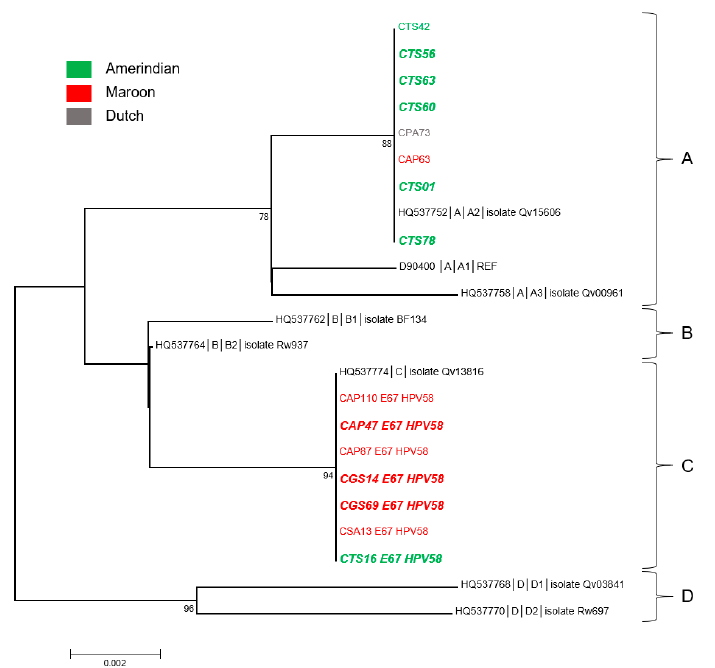
Figure 5. Phylogenetic tree of HPV58 variants from French Guiana. Maximum likelihood phylogenetic tree of HPV58 variants based on 741 bp of E6 and E7 concatenated sequences. Four clusters were identified as lineages A, B, C, and D. Only bootstrap values above 70% are represented in the branches. The tree is drawn to scale with branch lengths measured in the number of substitutions per site. Newly generated sequences, here identified by their IDs, are color-coded according to the mother tongue of the women from whom they were obtained. Oversized sequences in bold and in italics are those obtained from women with an abnormal cytology (either ASCUS, ASC-H, LSIL, HSIL, or glandular